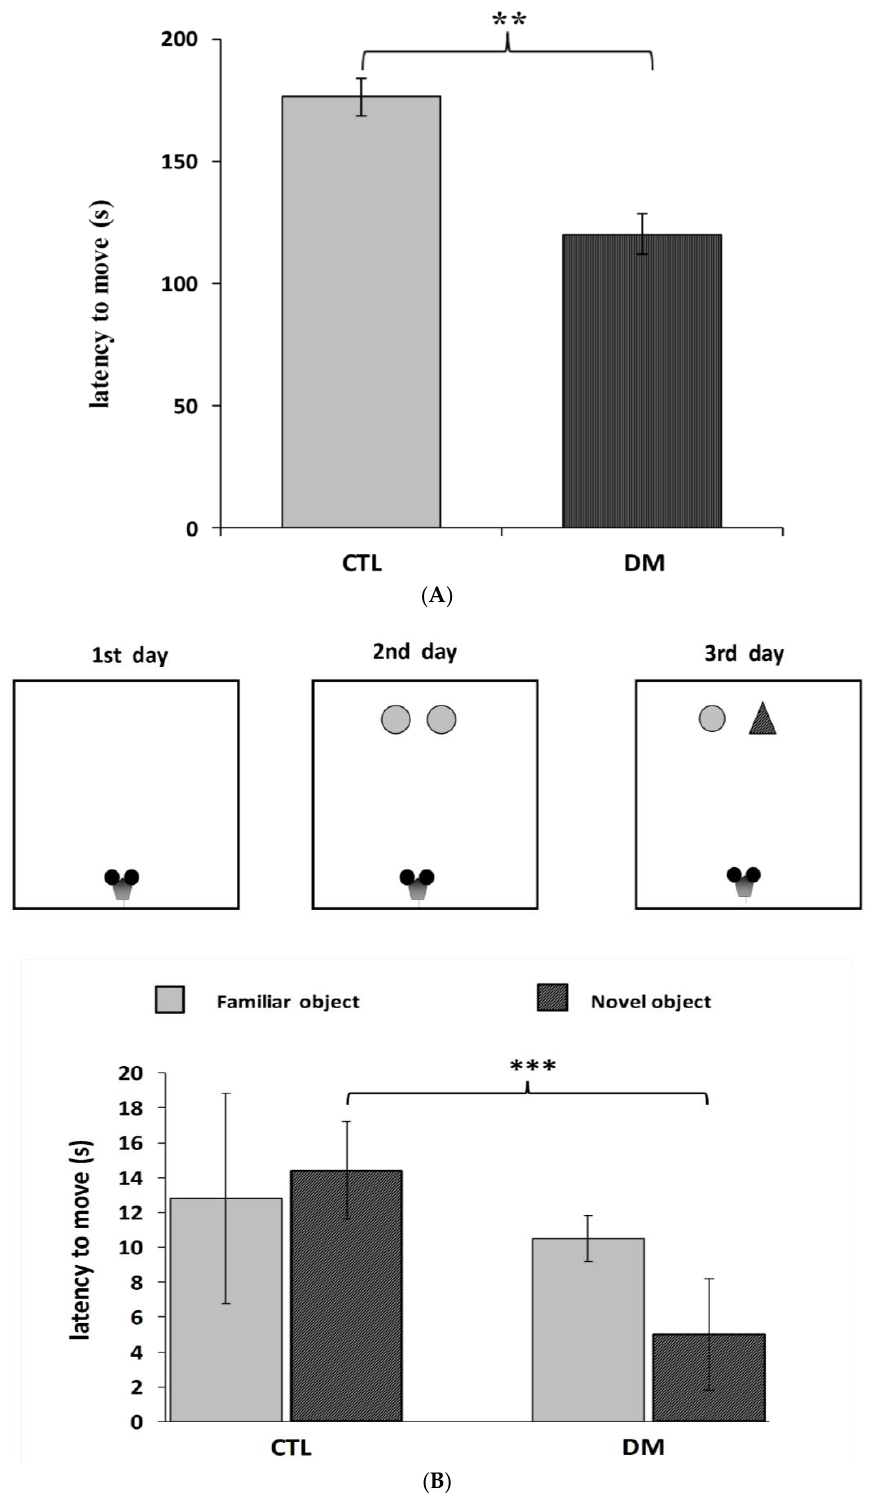
Figure 2. Influence of diabetes on learning and long-term memory process in mice. Passive avoidance (PA) test ( A ), “NOR-novel object recognition” test ( B ). Data are expressed as mean ± SEM ( n = 6). CTL: Control mice, DM: Diabetic mice. *** p < 0.001;** p < 0.01 vs. control.